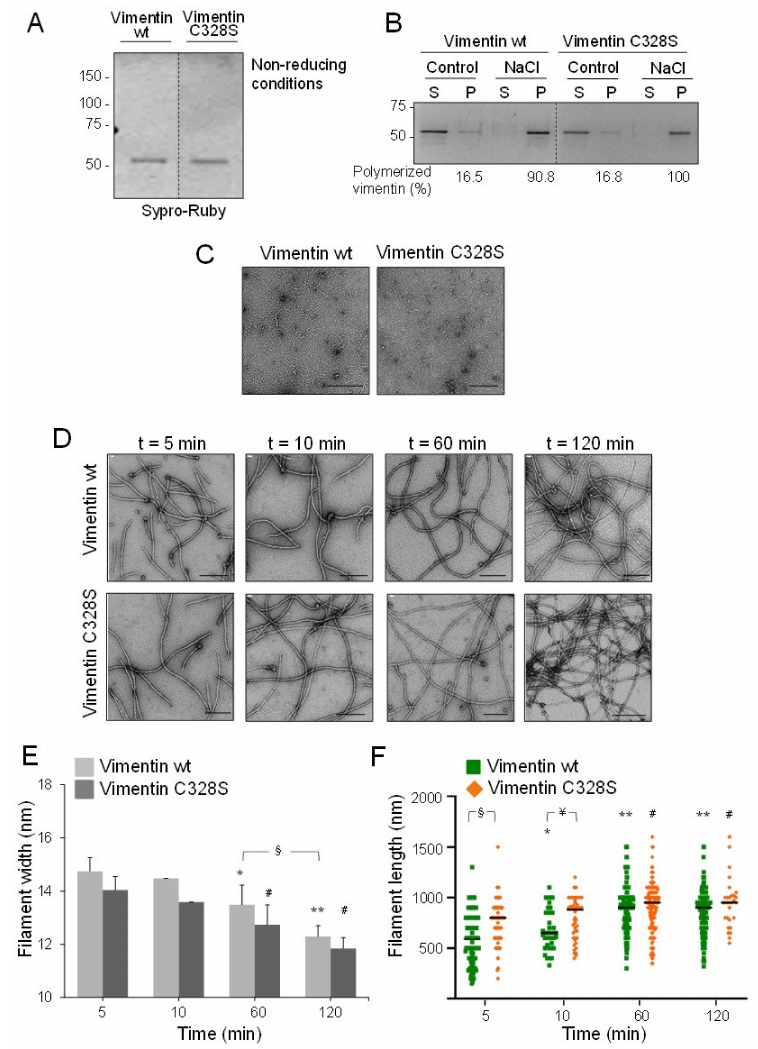
Figure 1. Polymerization of vimentin wt and C328S. ( A ) Vimentin purified and subjected to EDTA removal was analyzed by gel electrophoresis under non-reducing conditions. Total protein was stained with Sypro-Ruby. The position of molecular weight markers is indicated on the left. ( B ) Vimentin wt or C328S in 5 mM PIPES-Na pH 7.0, 0.2 mM DTT was incubated with 150 mM NaCl for 15 min at 37 ◦ C and polymerization assessed by ultracentrifugation. Supernatant (S) and pellet (P) fractions, containing soluble and polymerized vimentin, respectively, were analyzed by SDS-PAGE and Sypro-Ruby staining. The amount of vimentin in each fraction was estimated by image scanning, and the percentage of polymerized vimentin is shown below the gel. Results are representative of five assays. ( C ) Soluble vimentin wt and C328S preparations were analyzed by electron microscopy (EM). Images are representative of four and 10 preparations of vimentin wt and C328S, respectively. ( D ) Vimentin assembly was induced by the addition of 150 mM NaCl at 37 ◦ C, and filament formation at the indicated times was monitored by EM. Images are representative of at least three assays. Images were analyzed with FIJI to determine filament width and length under the di ff erent conditions for both vimentin preparations, and the results are shown in ( E ) and ( F ), respectively. Results are average values ± SEM of 50 to 200 filaments per condition. In ( E ), * p < 0.05, and ** p < 0.001 vs. vimentin wt at 5 min, # p < 0.05 vs. vimentin C328S at 5 min, § p < 0.05, as indicated. In ( F ), * p < 0.05, and ** p < 0.0001 vs. vimentin wt at 5 min, # p < 0.05 vs. vimentin C328S at 5 min, § p < 0.0001, ¥ p < 0.05, as indicated, by the unpaired Student’s t -test. Scale bars, 200